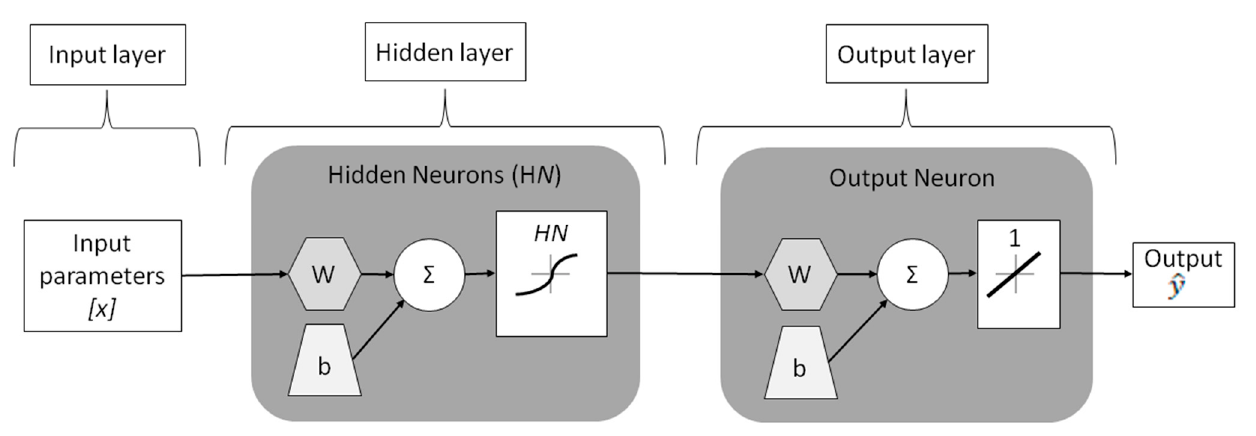
Figure 1. FFNN forecaster’s layout. Table 2. FFNNs structures’ averaged results for fixing hidden layer’s number of neurons.